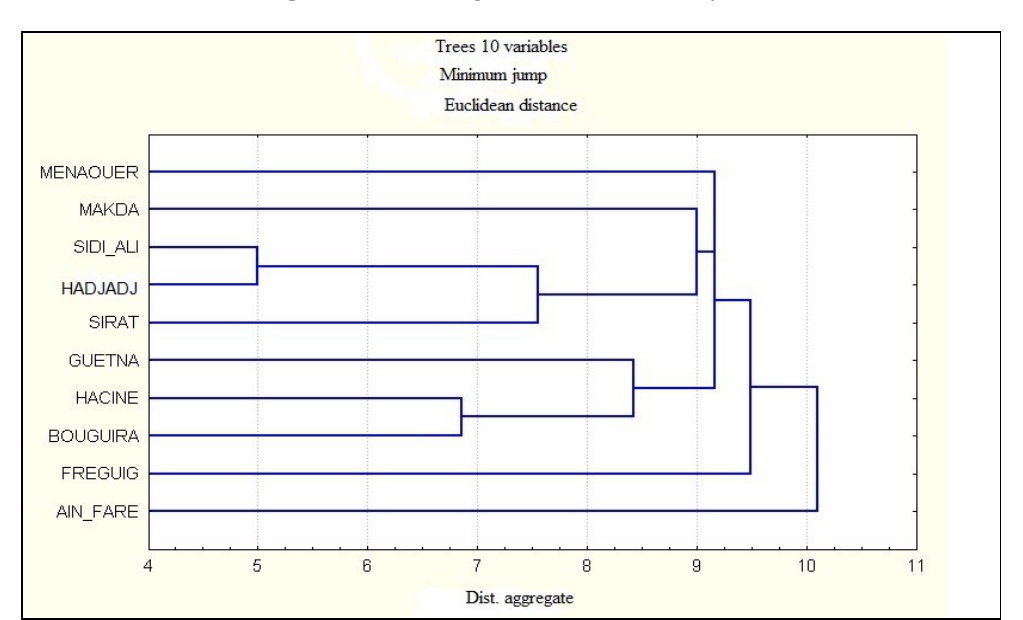
Figure 2. Dendrogram of cluster